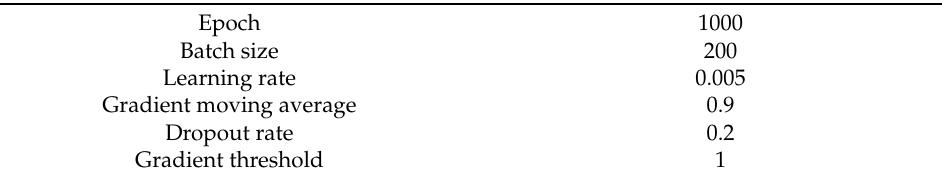
Table 1. Training parameters of GRU network.